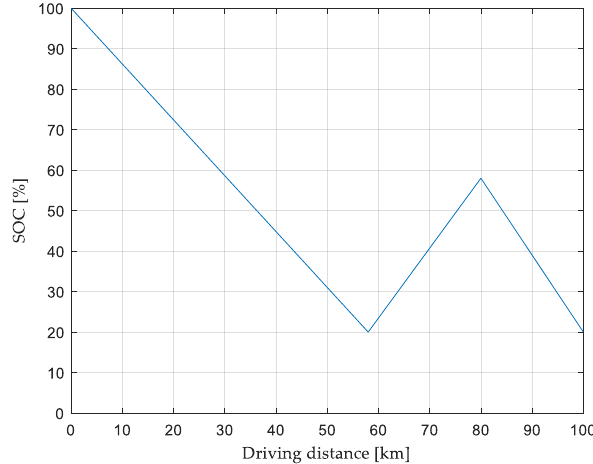
Figure 9. SOC of battery in electric vehicle after optimization, distance = 100 km.